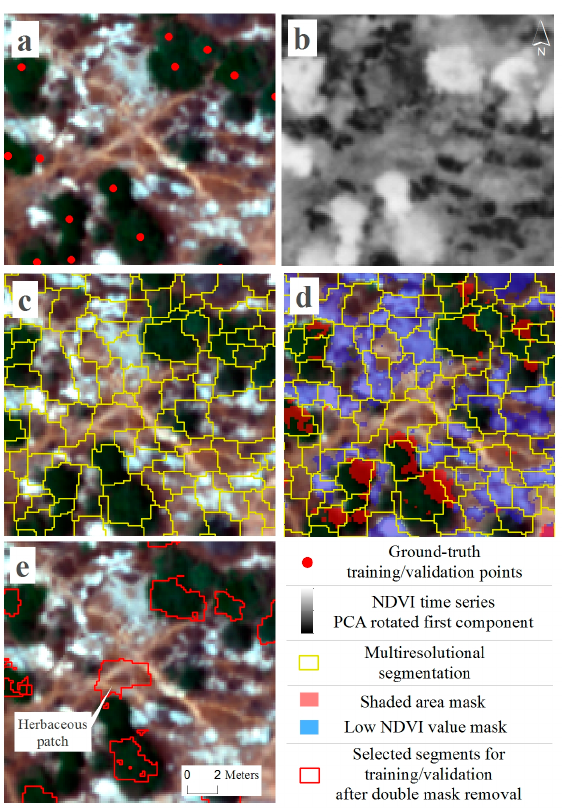
Figure 4. Illustration of the classification preprocessing of the UAV imagery in the Mata (M) site. ( a ) Points represent individual trees and shrubs whose species were determined in the field. The background image presents the visible bands as acquired on 18 June 2017; ( b ) First principal component of NDVI time series; ( c ) Multi-resolution segmentation of the first PCA component; ( d ) Shaded area mask and low NDVI mask; ( e ) Segments that were selected for training and validation. Only segments that represented an illuminated part of the canopy (after the double mask removal) were included.